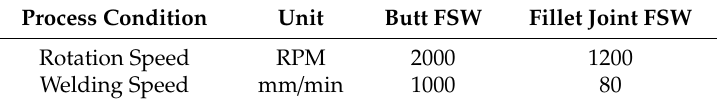
Table 5. Optimal process condition.